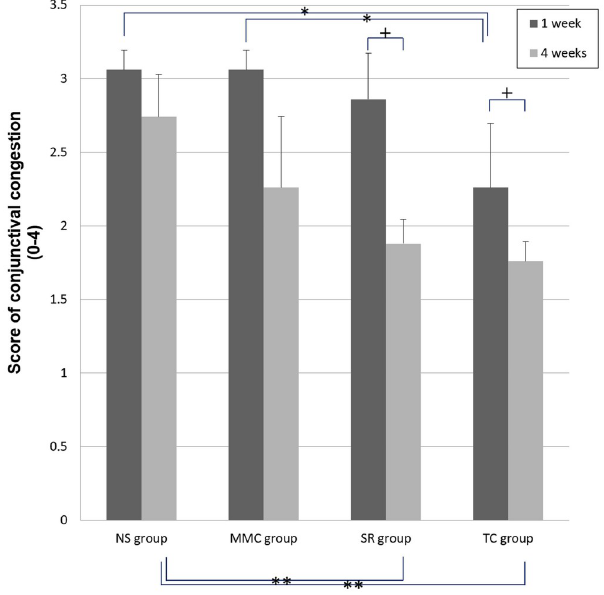
Fig 5. Conjunctival congestion in the rabbit at 1 and 4 weeks postoperatively. � = significant difference in conjunctival congestion at 1 week among all groups ( p < 0.05, Kruskal–Wallis test and Games–Howell adjustment), �� = significant difference in conjunctival congestion at 4 weeks among all groups ( p < 0.05, Kruskal–Wallis test and Games–Howell adjustment), † = significant difference between 1 and 4 weeks postoperatively ( p < 0.05, Wilcoxon signed-rank test). NS = 0.9% normal saline, MMC = 0.5% mitomycin C, SR = sirolimus, TC = tacrolimus.